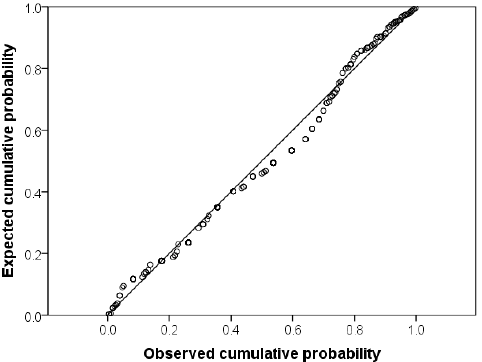
Figure 4. P-P graph of logarithm of the detected daily average concentrations of Hg.